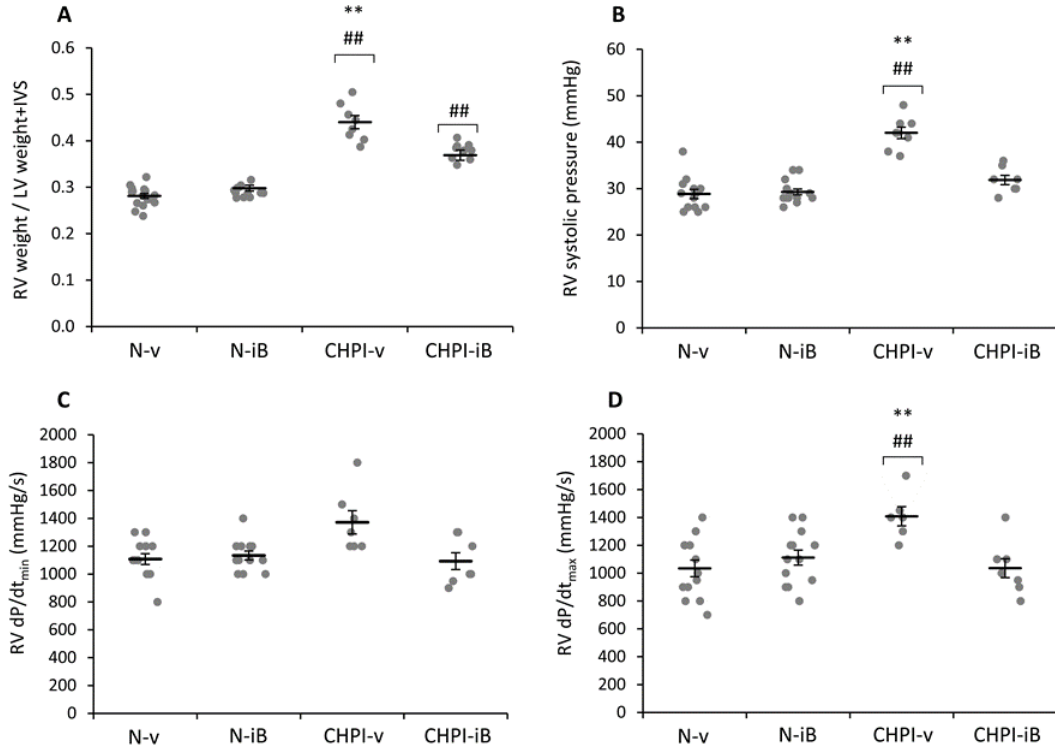
Figure 2. Effect of I-BET151 administration on the morphology and function of the right ventricle. Ratio of weights of the right ventricle to the left ventricle plus interventricular septum ( A ); right ventricular systolic pressure ( B ); right ventricular relaxation time; ( C ) and contraction time ( D ). IVS: Interventricular Septum; RV: Right Ventricle; N-v: Normoxia + vehicle; N-iB: Normoxia + I-BET (inhibitor of Bromodomains and Extra-Terminal domains); CHPI-v: Chronic Hypoxia + Inflammation + vehicle; CHPI-iB: Chronic Hypoxia + Inflammation + I-BET151. Horizontal bars represent the mean ± SEM; n = 7–16. ##: diff. from N-v and N-iB ( p < 0.001); **: diff. from CHPI-v ( p < 0.001).